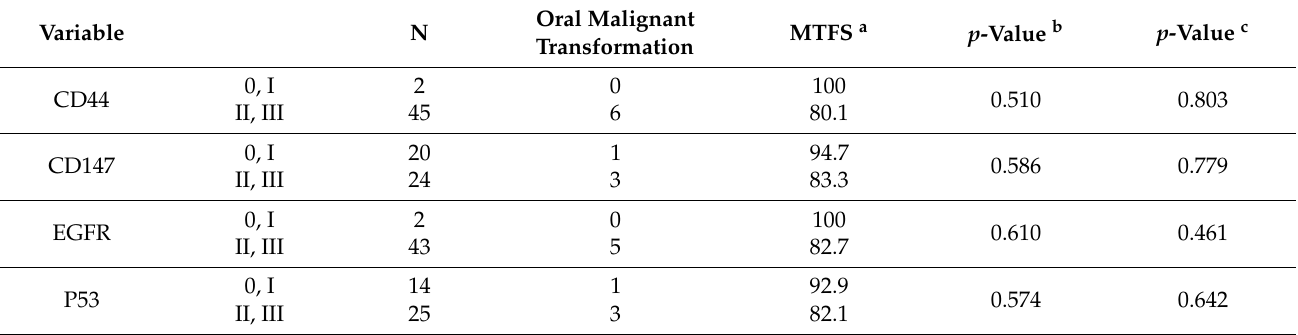
Table 2. Univariable analysis of the influence of variables in the oral malignant transformation-free survival using Kaplan–Meier